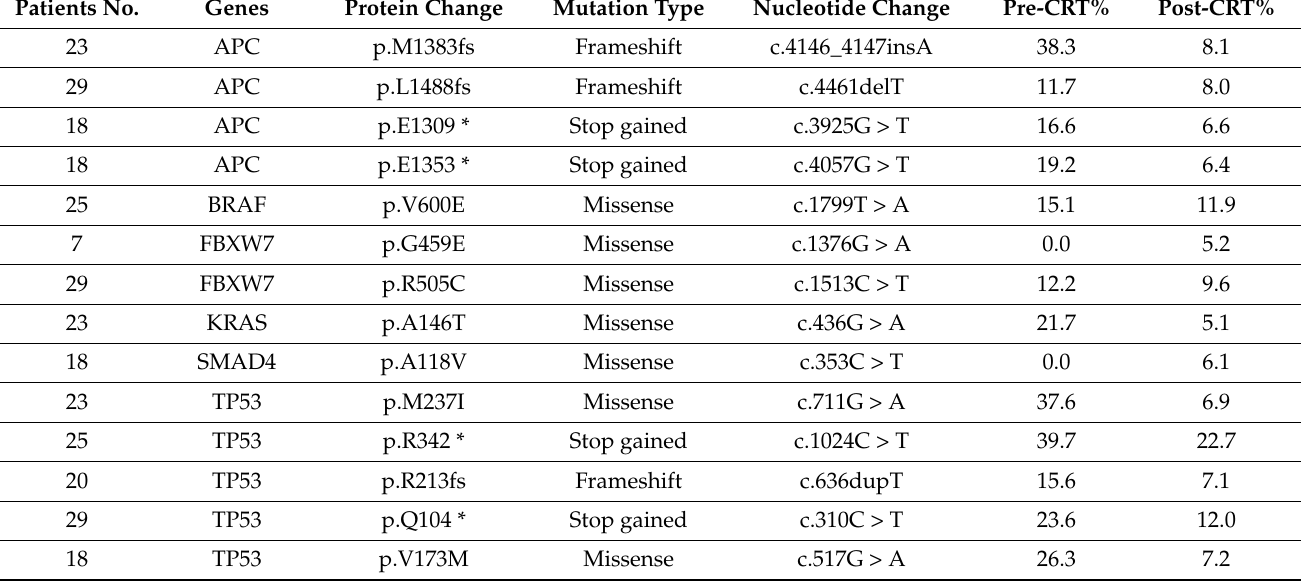
Table 3. Gene mutations retained in rectal carcinoma after nCRT.